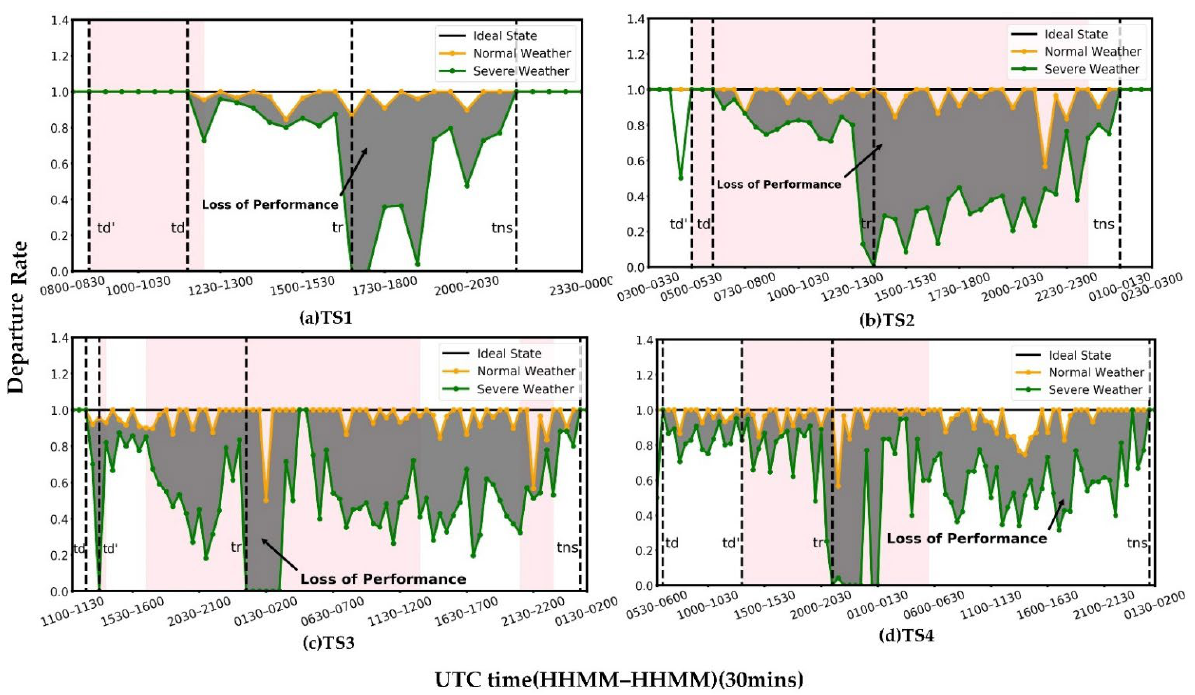
Figure 5. Airport flight operation resilience performance under TSs.